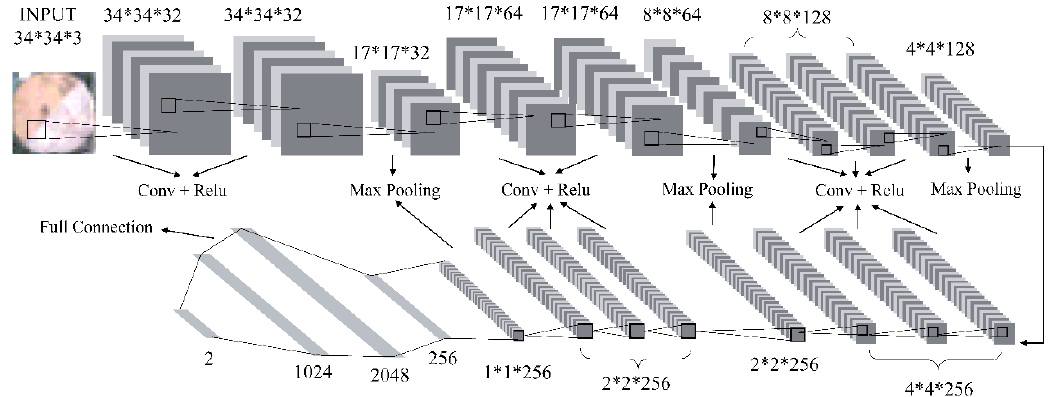
Figure 7. Architecture of CNNs for identification of center pivot irrigation systems following the VGGNet structure.